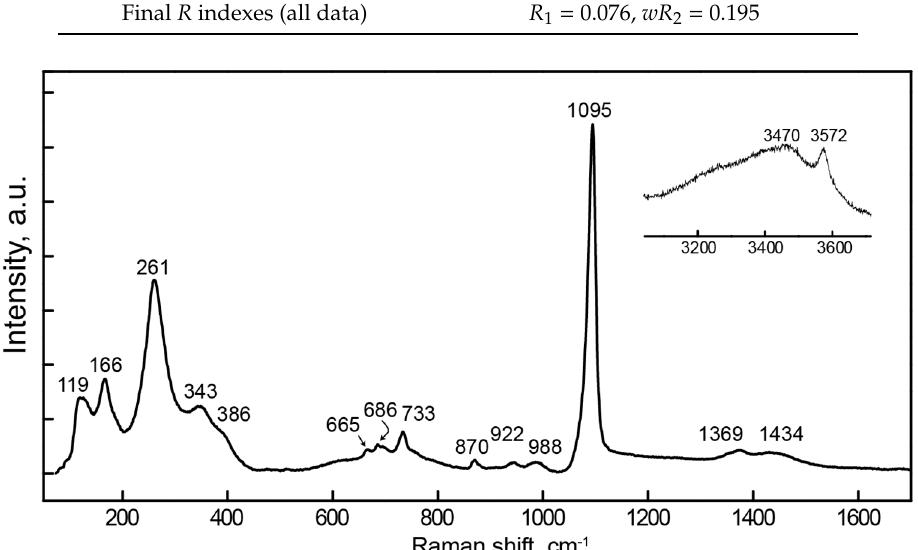
Figure 1. Raman spectrum of paratooite-(La).